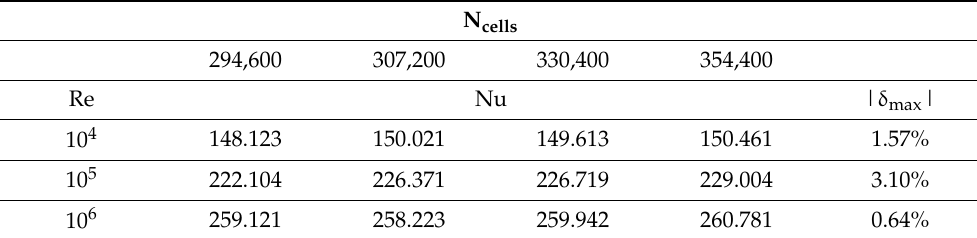
Table 4. Mesh effect on the average Nusselt